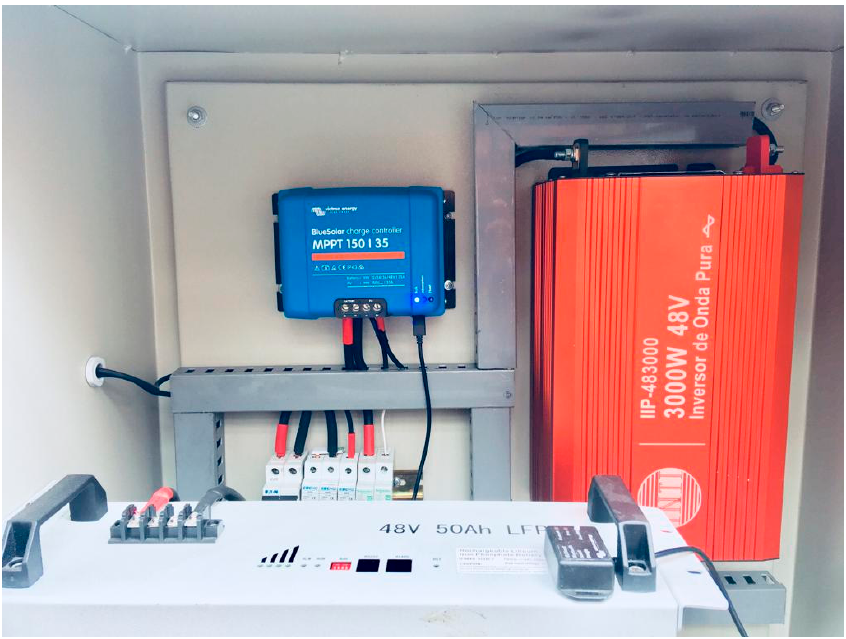
Figure 11. BlueSolar Charge Controller MPPT 150/35.